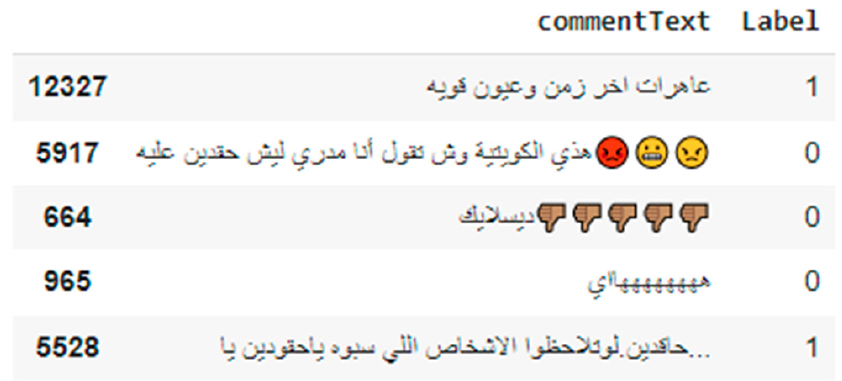
Figure 3. Examples of comments from the dataset.